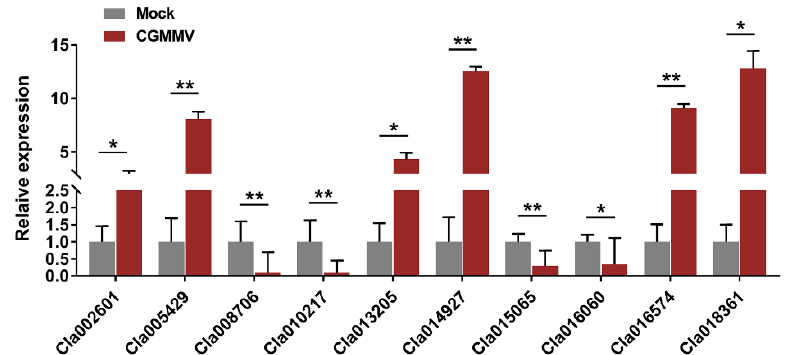
Figure 5. Validation of isobaric tags for relative and absolute quantitation (iTRAQ) data by quantitative reverse-transcription PCR (qRT-PCR). The watermelon 18S rRNA gene was used as an internal control. Three independent experiments were conducted with at least three biological replicates each. Error bars represent mean ± standard deviation (SD). Asterisks indicate statistically significant differences compared to the control (Student’s t -test). (** p < 0.01, * p < 0.05).